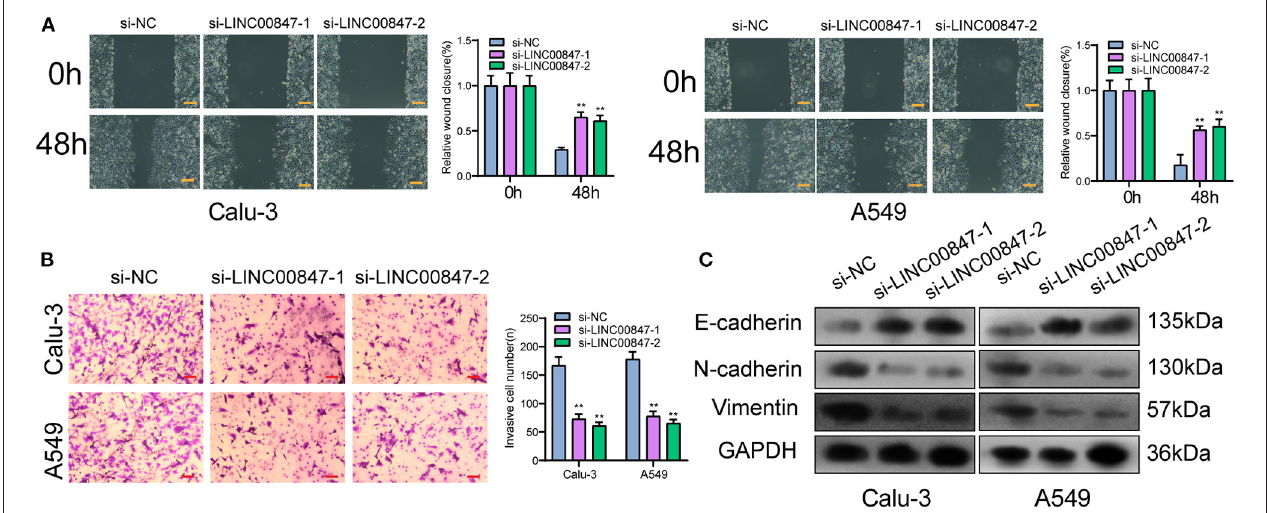
FIGURE 4 | LINC00847 dramatically influenced the invasion, migration and EMT progress of NSCLC cells. (A) Wound healing assays were used to detect cell invasion in LINC00847-knockdown-Calu-3 and A549 cells. (B) Trans well assays were carried out in Calu-3 and A549 cells after knockdown of LINC00847. (C) Western blot examined the levels of EMT-related factors after knockdown of LINC00847. ** p <